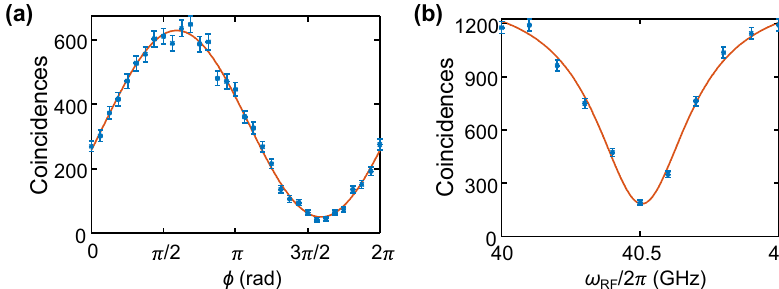
Fig. 5 | Characterization of residual BFC spectral phase and FSR of MRR. Two adjacent signal-idler bin pairs are selected and equally mixed using an EOM. Biphoton time-correlation functions of one energy-matched pair are then mea- sured. a Coincidences at τ =0 as joint spectral phase ϕ is swept. b Coincidences